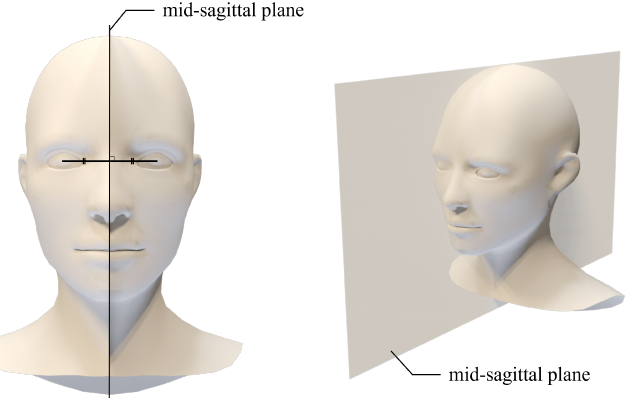
Figure 4. Facial midsagittal plane. The vertical bisector of the line connecting the irises is the midsagittal line, which is expanded to a 3D image to define the midsagittal plane.